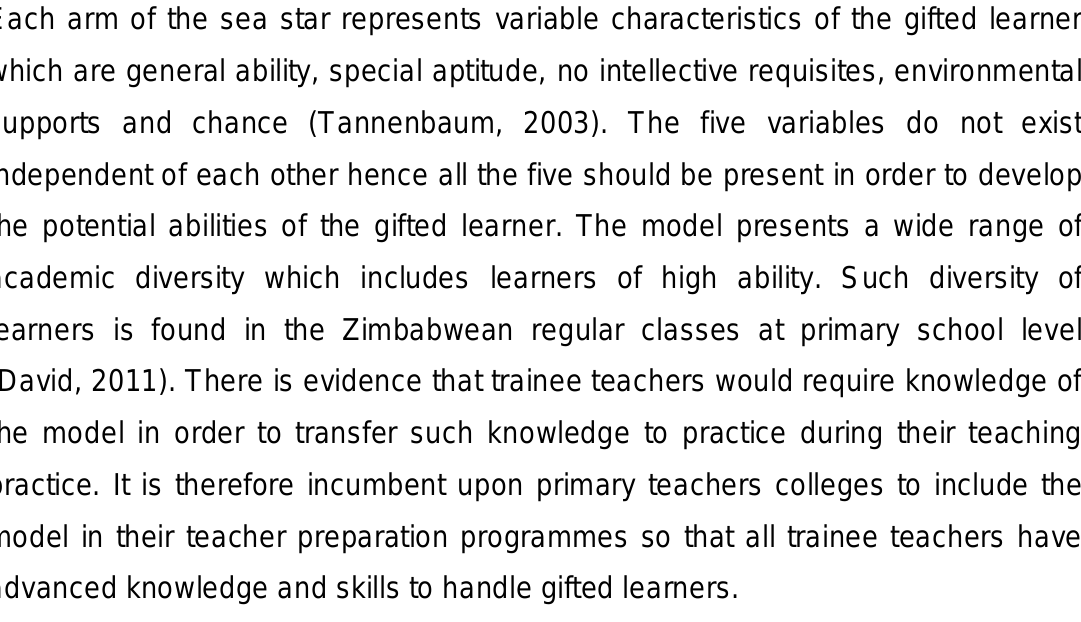
Figure 2.5 Tannenbaum's 'sea star' model Adapted from Tannenbaum